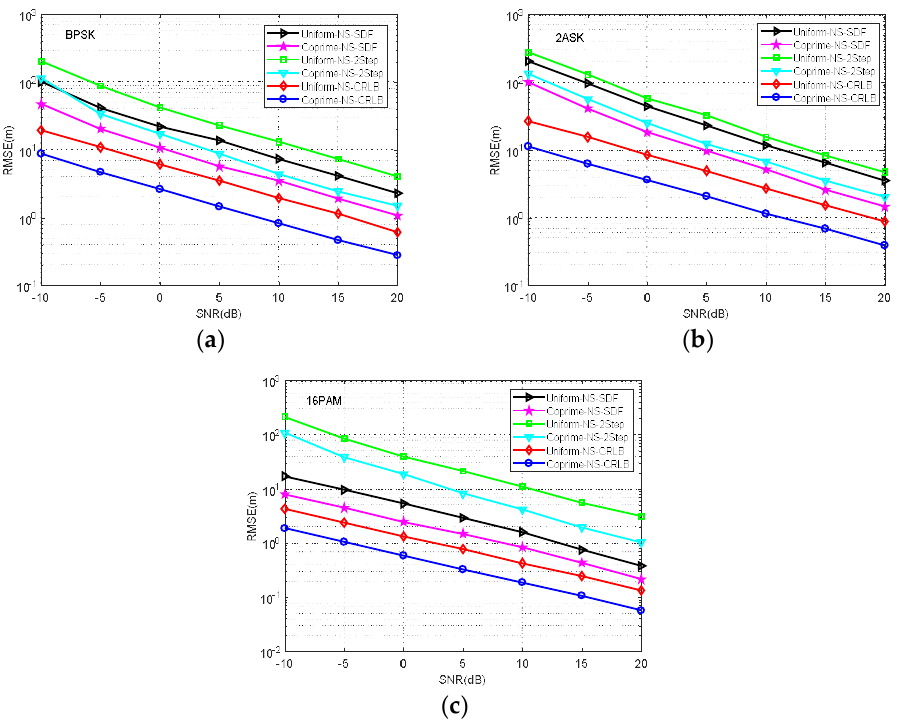
Figure 13. RMSE comparison of different modulation signals (NS). ( a ) BPSK ( b ) 2ASK ( c ) 16PAM